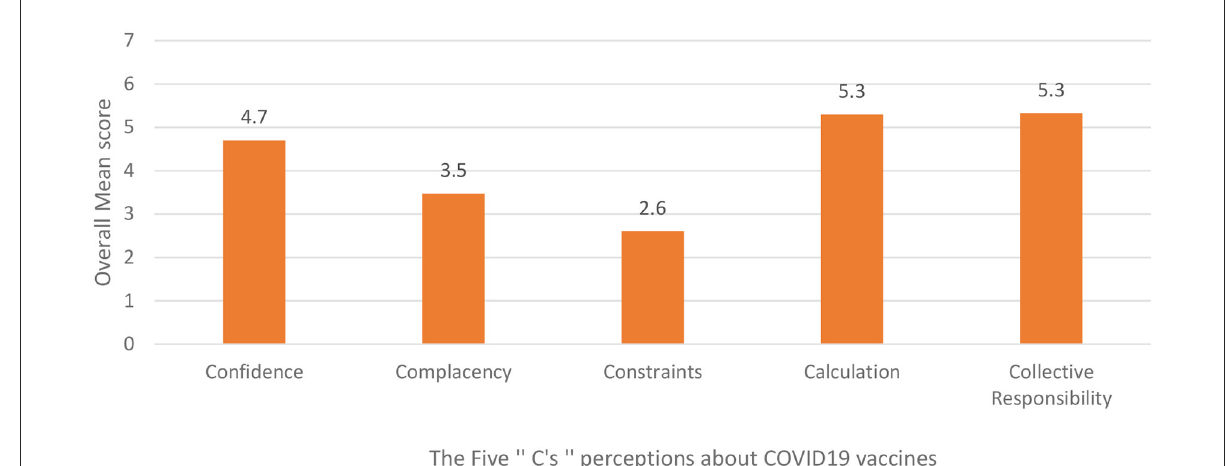
FIGURE1 Participants’ overall mean perceptions of the 5C